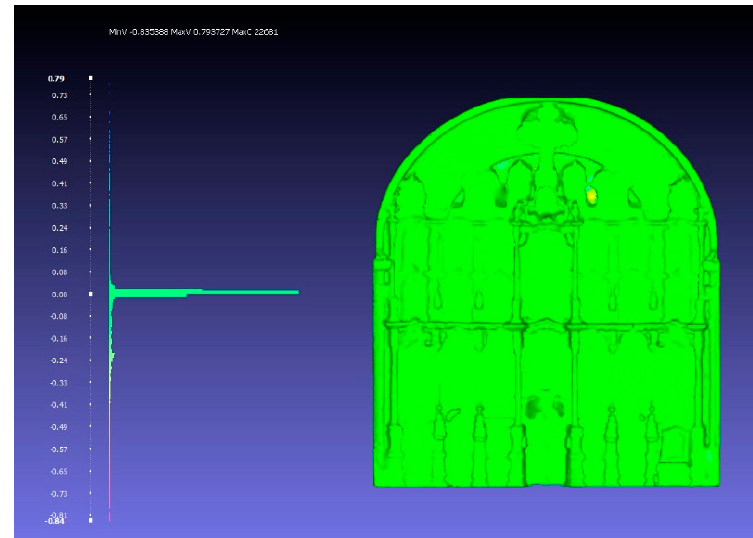
Figure 10. Comparison of starting high-poly model with low-poly with high-poly details.